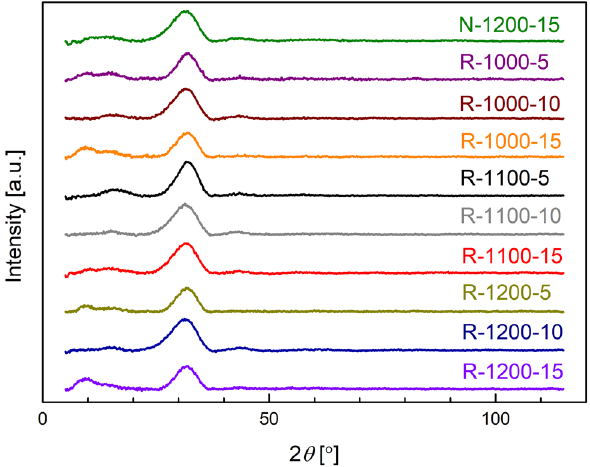
Figure 1. XRD patterns of all synthesized materials. The labels denote the preparation conditions: the atmosphere (N-air, R-reducing atmosphere), temperature of the melting stage (in cf. Table 1).